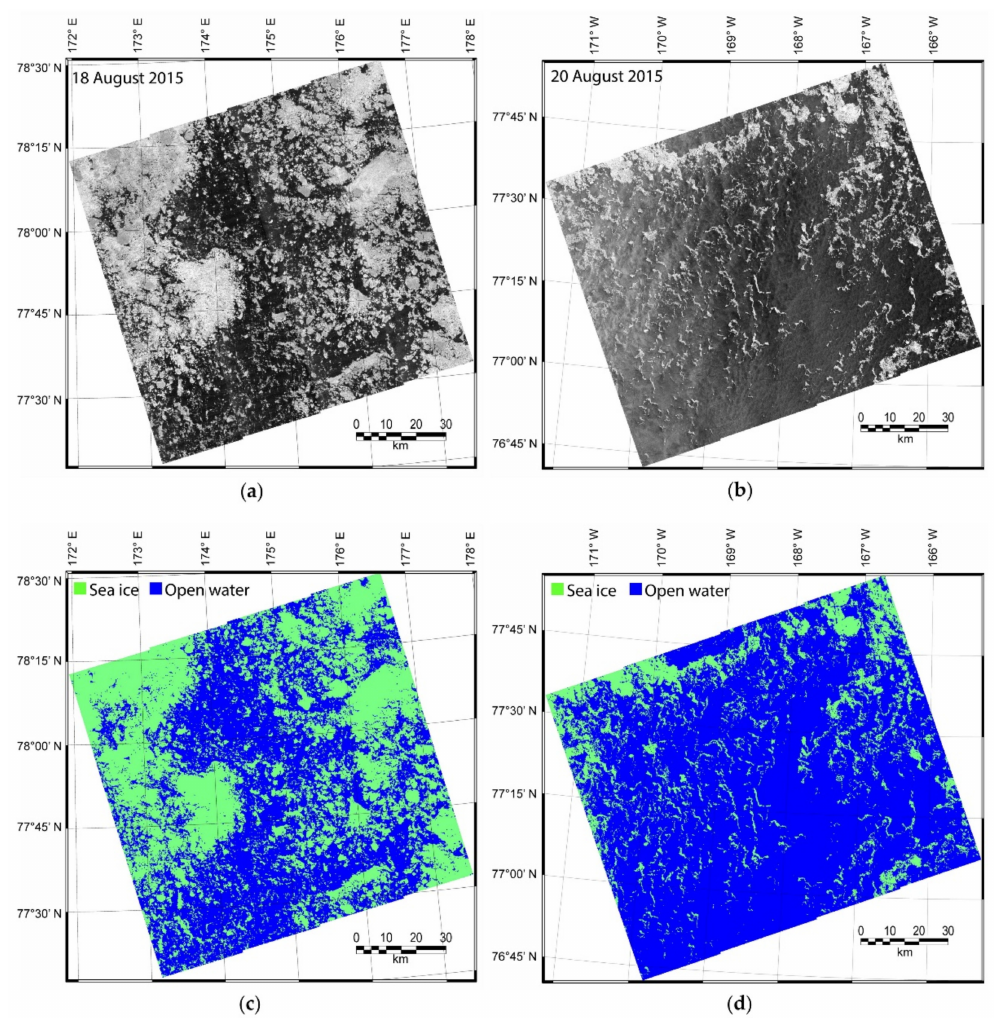
Figure 2. Examples of ( a , b ) KOMPSAT-5 EW SAR images and ( c , d ) corresponding ice/water maps, modified from Han and Kim